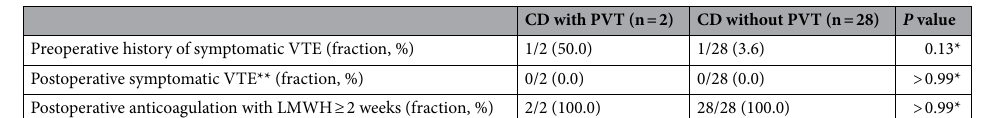
Table 3. Occurrence of symptomatic venous thrombotic events (VTE) before and after transsphenoidal surgery for Cushing’s disease (CD) in patients with and without asymptomatic perioperative venous thrombosis (PVT) of the lower extremity under anticoagulant protection with low molecular weight heparin (LMWH). *Fisher’s exact test (two-sided). **Mean clinical follow-up 7.4 ± 6.9 months, minimum 3 months.